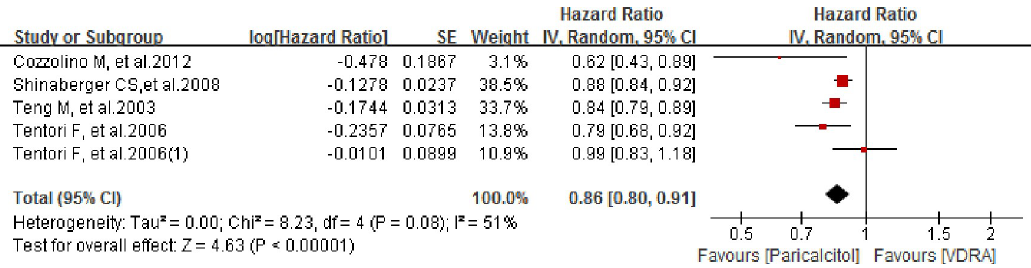
Fig 4. Forest plot of comparison between paricalcitol and VDRA regarding to overall survival.